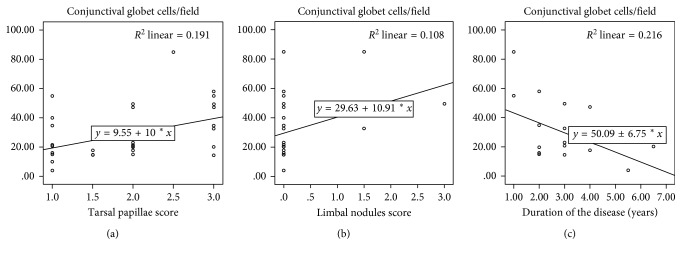
The greatest number of conjunctival goblet cells correlates significantly with the greater severity of the tarsal papillae (p=0.005, R = 0.499) (a), and limbal nodules (p=0.047, R = 0.328) (b). In addition, inverse correlation between the number of goblet cells and the duration of the chronic disease was demonstrated (p=0.048, R = −0.465) for probable chronic damage to the conjunctival tissue (c).